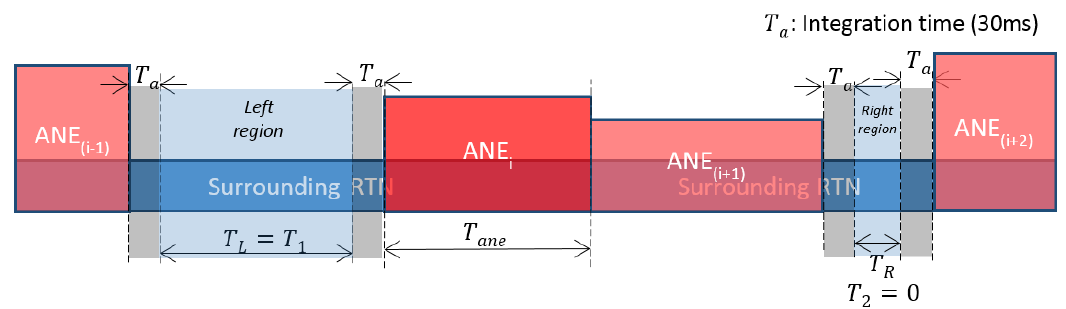
Figure 6. Other noise events occur just before and/or after the analyzed anomalous noise event. Example where all the samples considered for the SNR computation come from the left